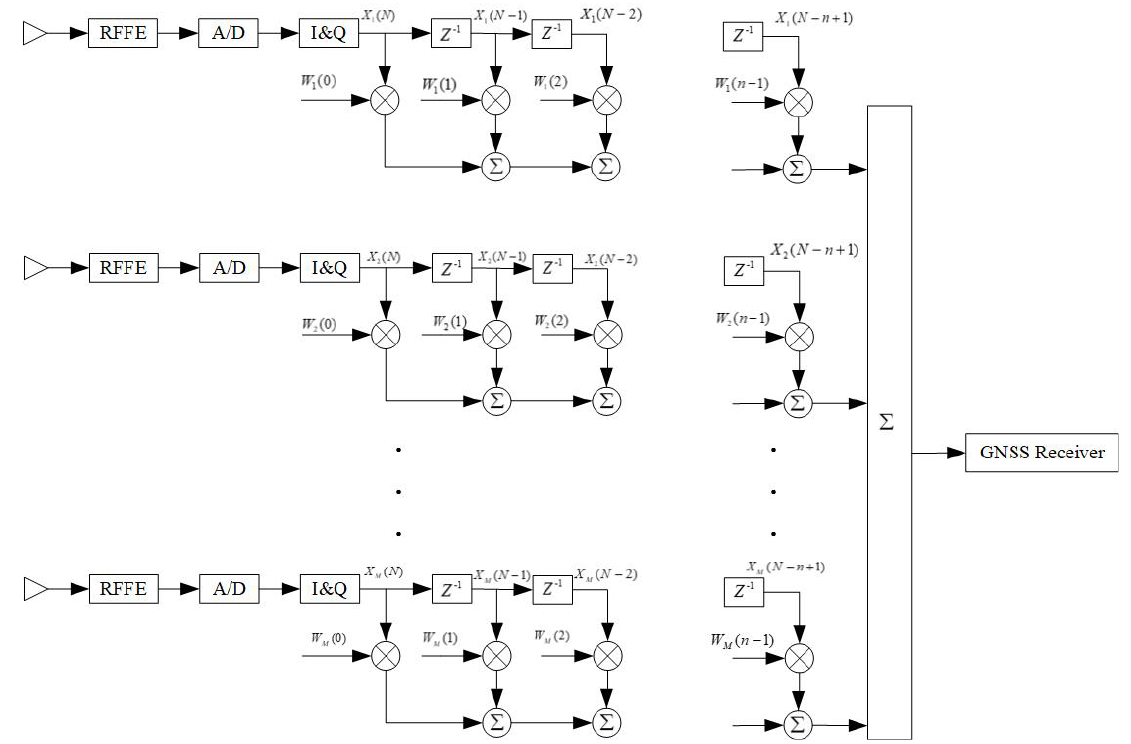
Figure 4. Space-time two-dimensional filtering algorithm.